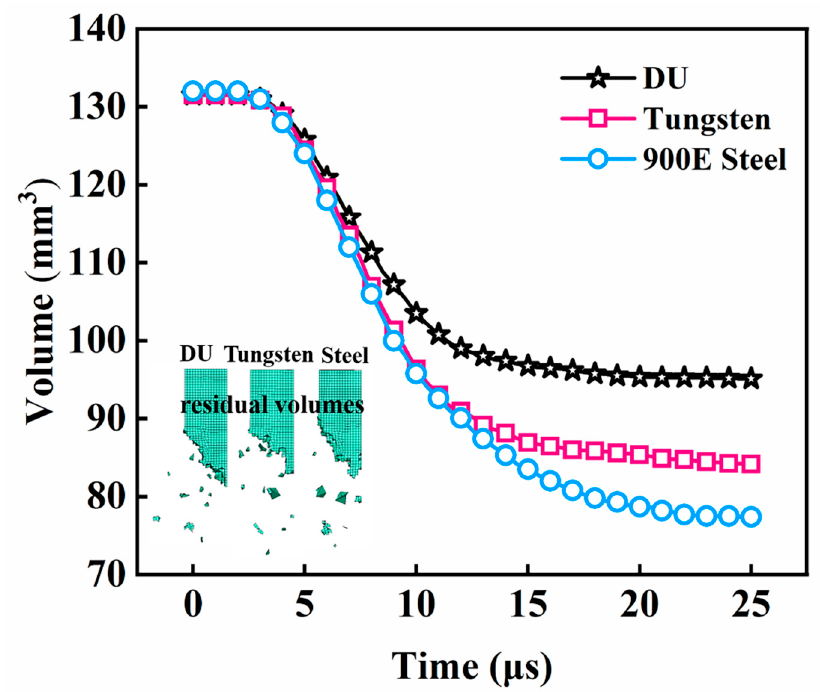
Figure 4. Variation of bullet volume with penetration time during penetration of different alloys.